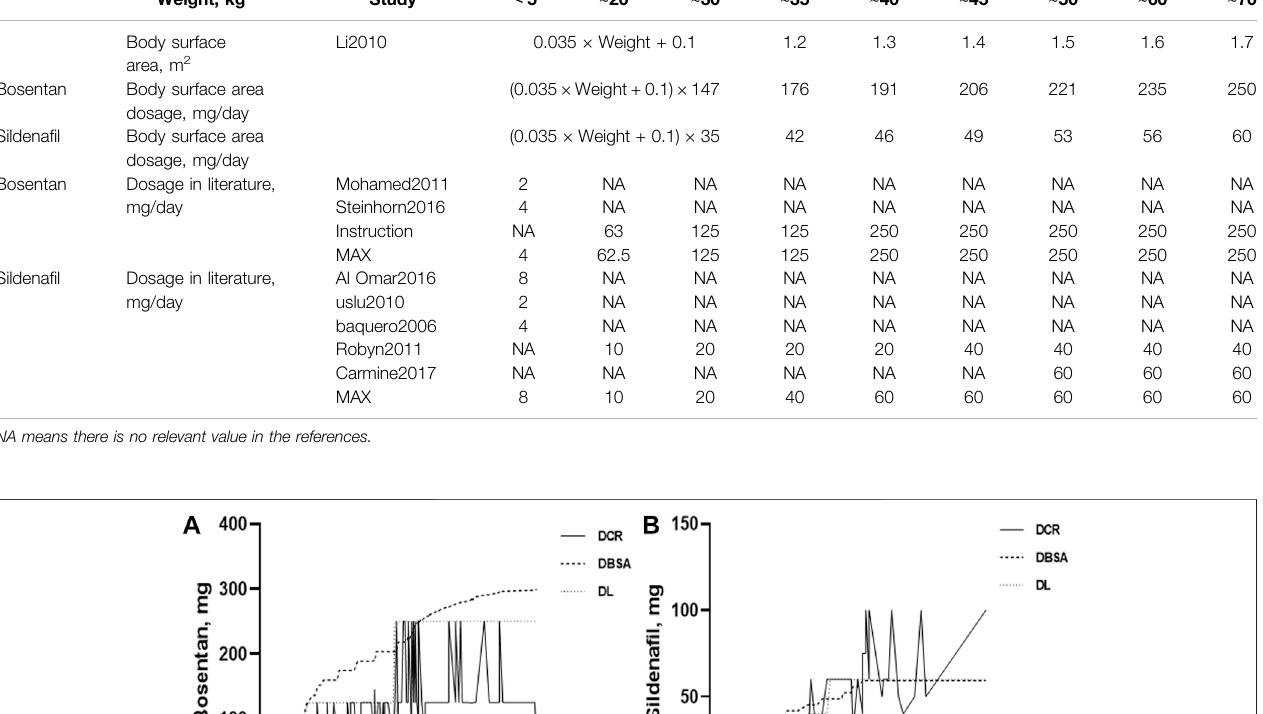
Frontiers in Pharmacology |